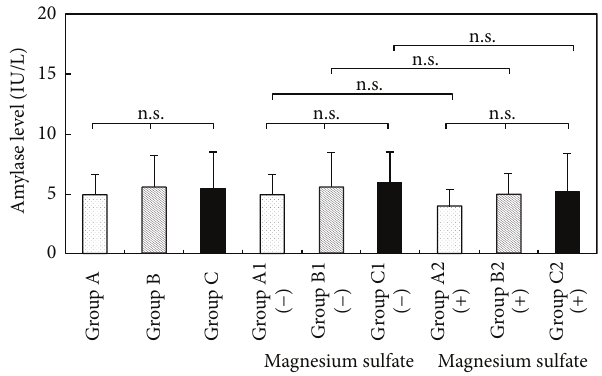
Figure 3: Amylase levels in umbilical blood after